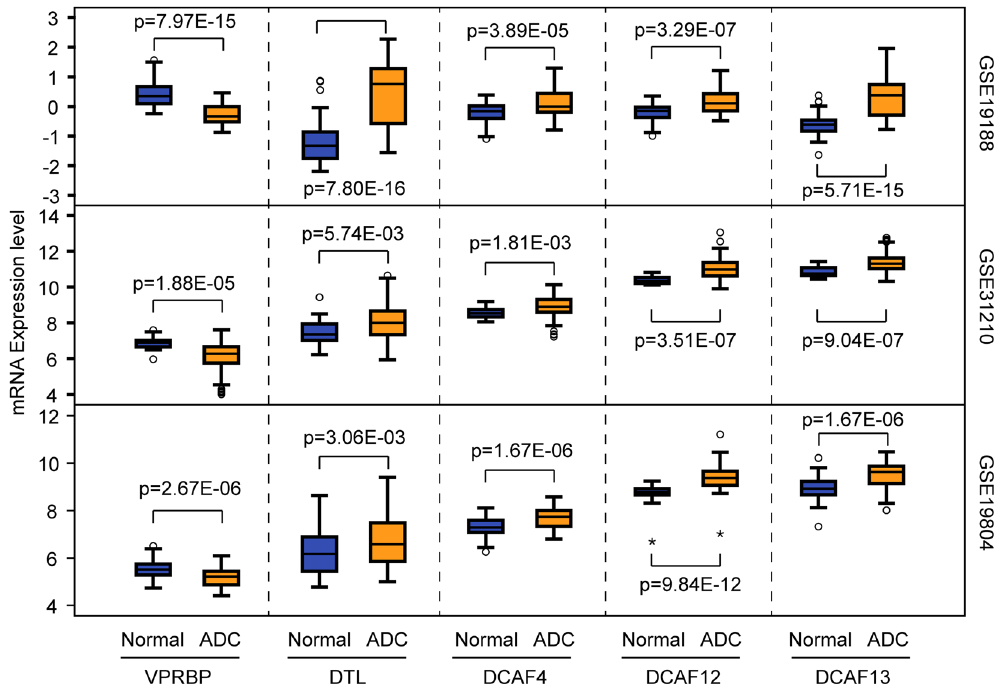
Figure 1. VPRBP , DTL , DCAF4 , DCAF12 and DCAF13 are consistently deregulated in lung adenocarcinoma. VPRBP gene expression was significantly downregulated, whereas DTL , DCAF4 , DCAF12 and DCAF13 were significantly upregulated in LuADCs (indicated in orange; GSE19188: N = 45; GSE31210: N = 226; GSE19804: N = 60) compared to expression in normal lung tissue (indicated in blue; GSE19188: N = 65; GSE31210: N = 20; GSE19804: N = 60). Increased or decreased gene expression cut-off: 2-fold and adjusted p <